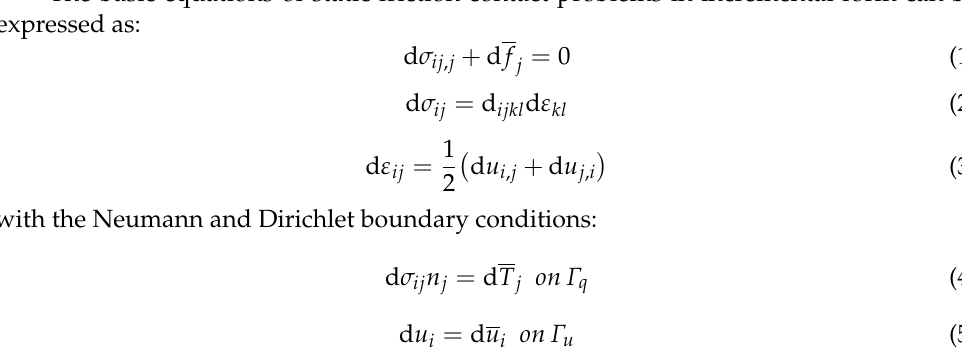
where d σ ij , d ε ij and d u i mean the stress increment, strain increment and displacement increment, respectively; d f means the body load increment; d T j means the given stress j increment; d u i means the given displacement increment; D ijkl means the elastic matrix; and n j means the outward unit vector. The incremental formulations are the increments within a time evolution of the deformed state of both bodies. The friction contact conditions on the potential contact boundary Γ c are: (1) The contact pressures on the two contact surfaces are equal in magnitude and opposite in direction.